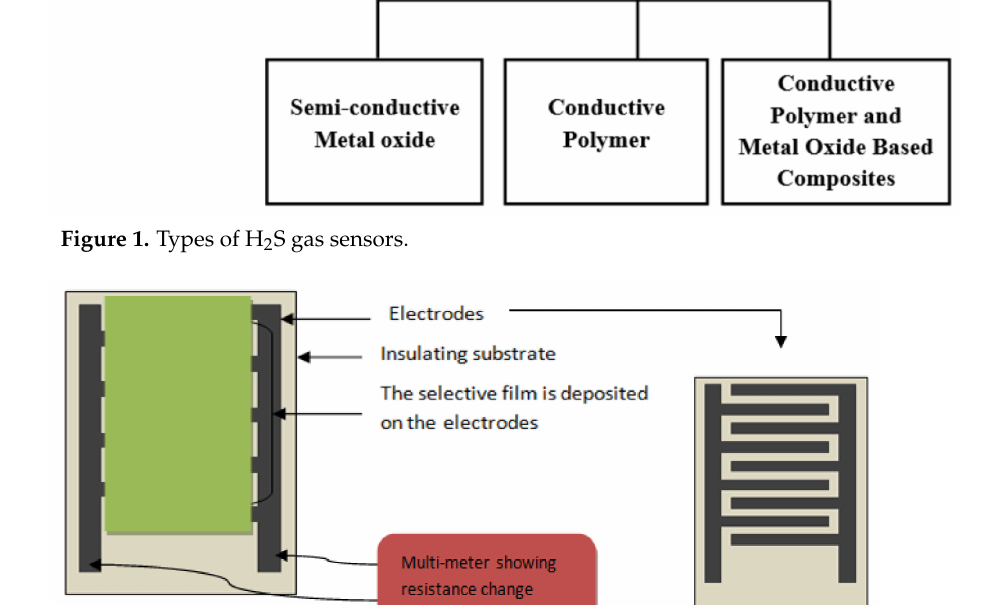
Figure 2. Schematic diagram of chemiresistive H 2 S gas